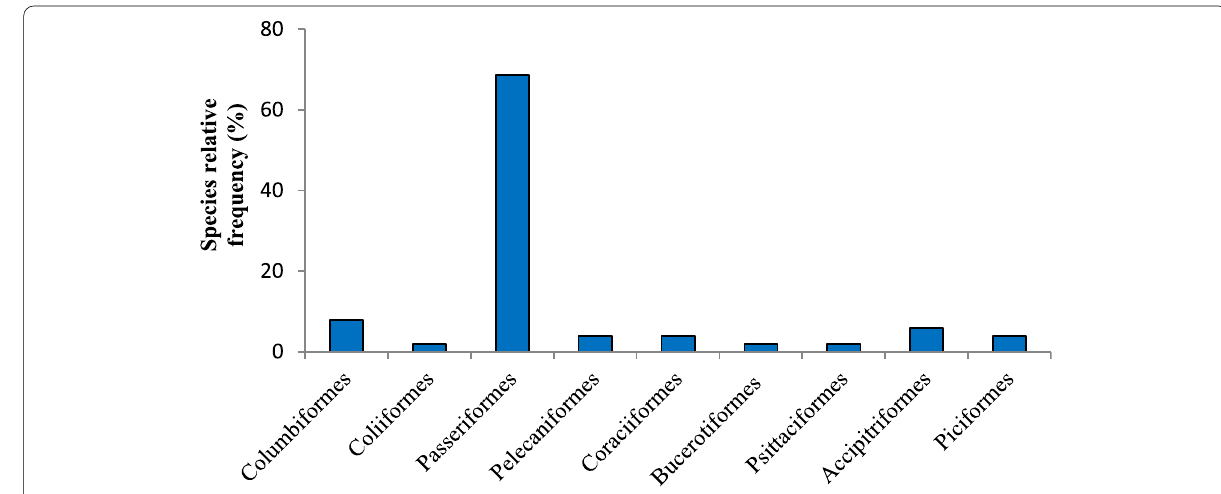
Fig. 2 Species composition of birds in their respective